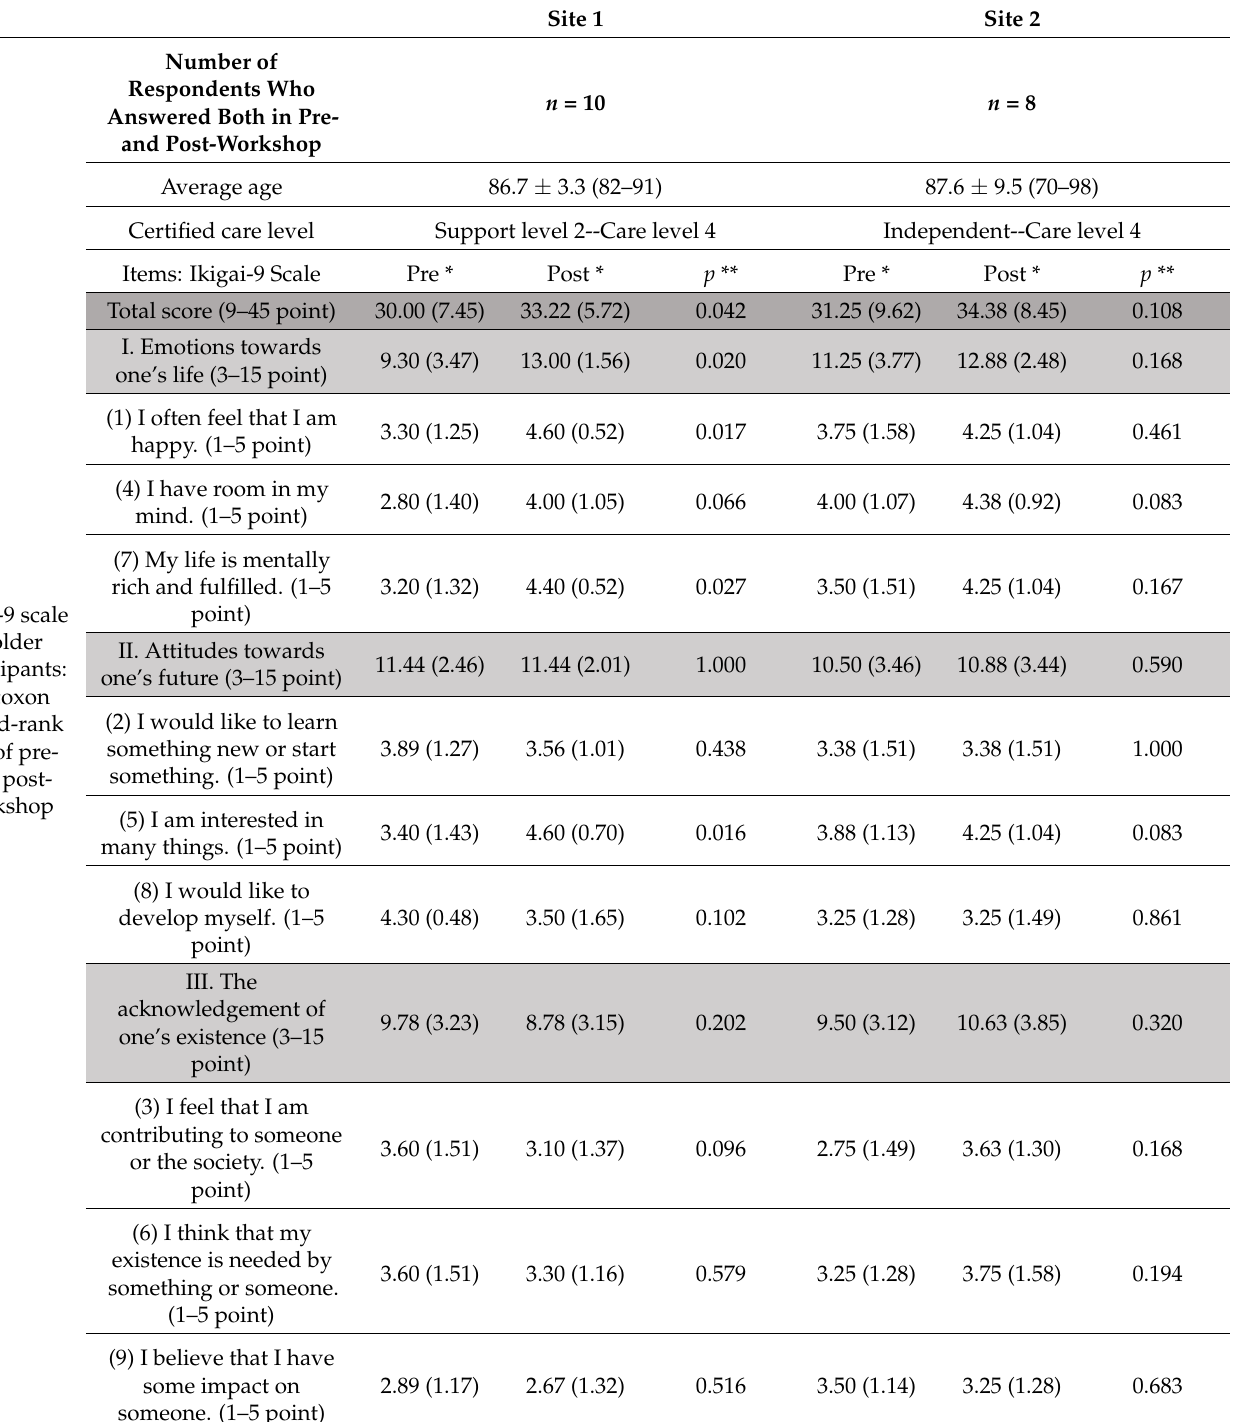
Table 3. The results of the Ikigai-9 scale of older participants’ Wilcoxon signed-rank test of the pre–post score ( n = 18) and the implementation environment of each